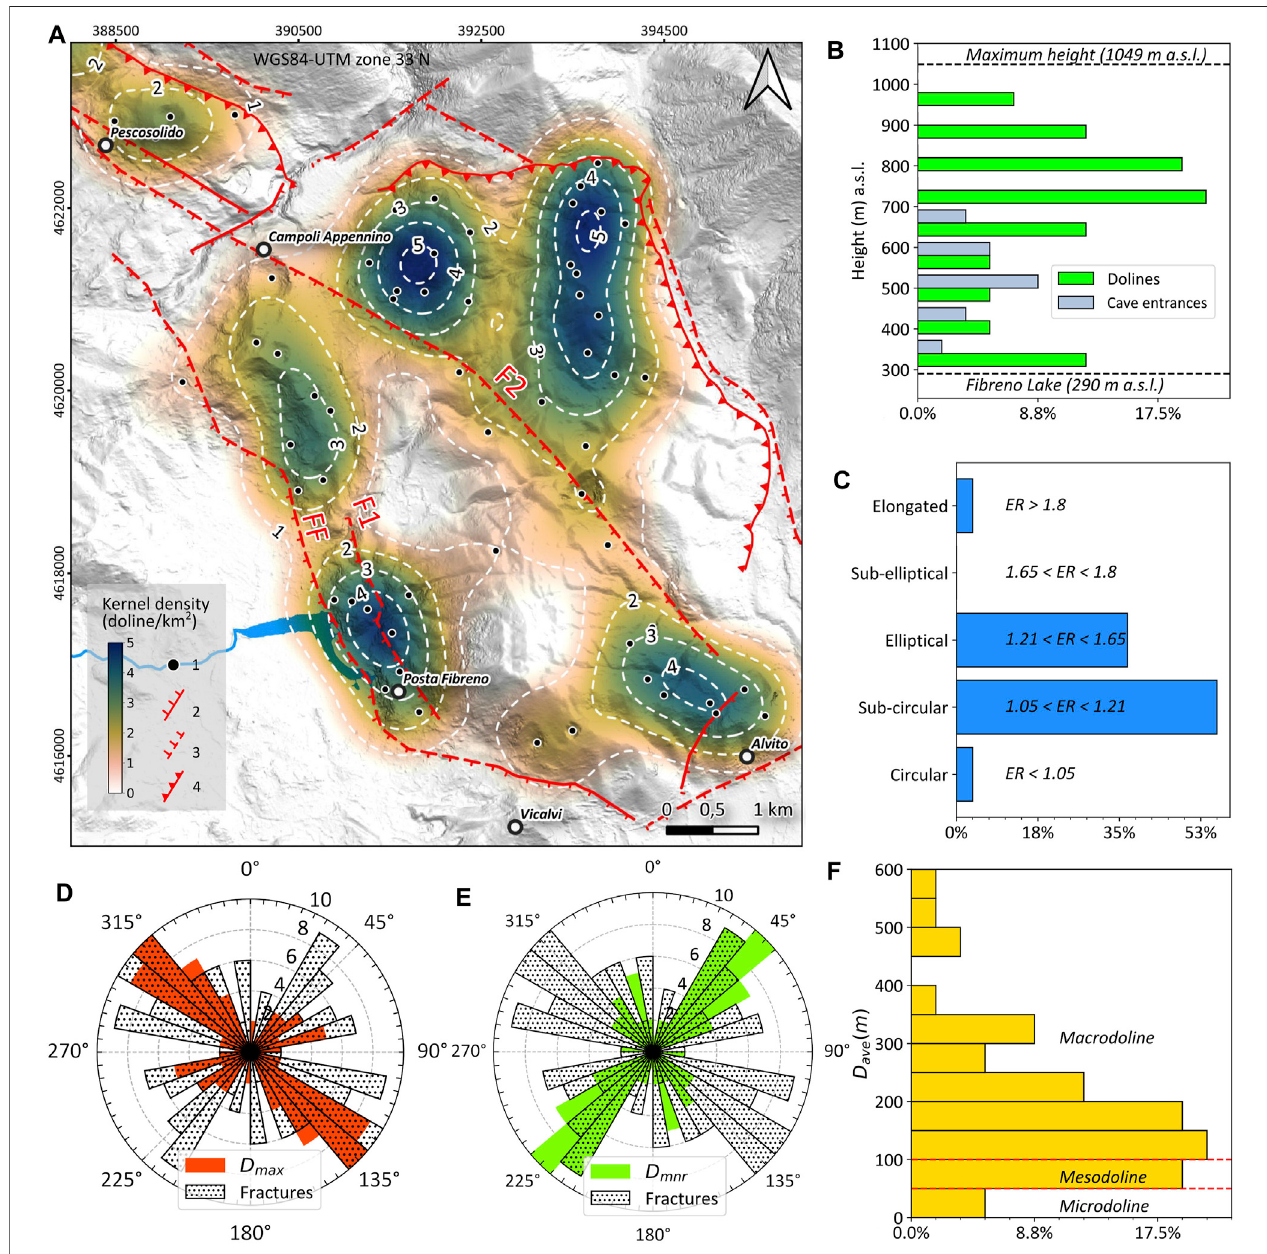
FIGURE 5 | Results of the performed morphometric analysis. (A) Kernel density distribution of the identi fi ed dolines. Key to the legend: 1) location of the deepest pointofthedoline;2)Normalfaults;3)Inferrednormalfaults;4)thrustfaults. (B) altimetricdistributionofdolinesandcaveentrances. (C) Dolineclassi fi cationaccordingto the elongation ratio (ER). (D) and (E) Rose diagrams showing the orientation of maximum ( D max in panel d) and minor ( D mnr in panel e) doline diameter, together with the fracture orientations from geomechanical surveys (Figure 4D) . (F) Distribution of the average doline diameter ( D ave ).